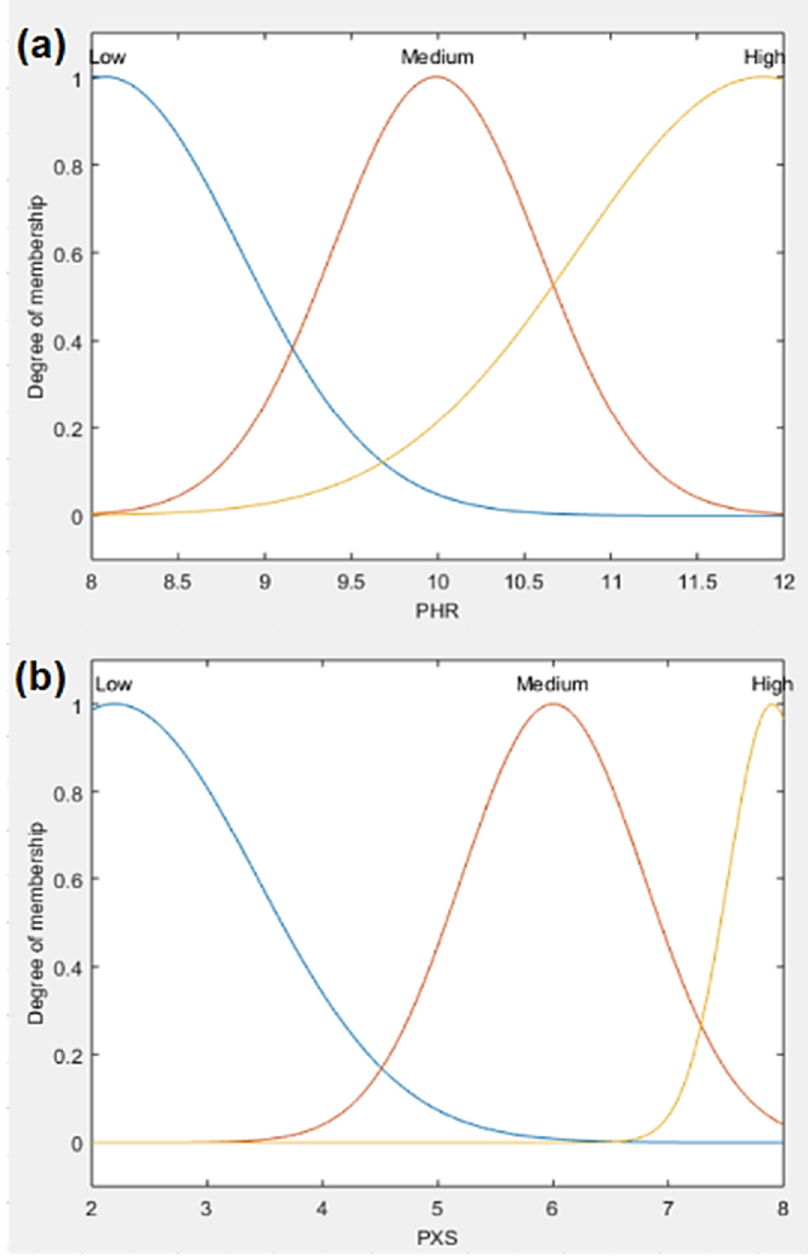
Figure 5. Example of defining the parameters of membership functions in the PSM: ( a ) pH value at rougher flotation circuit (PHR); ( b ) collector consumption in scavenging circuit (PXS).